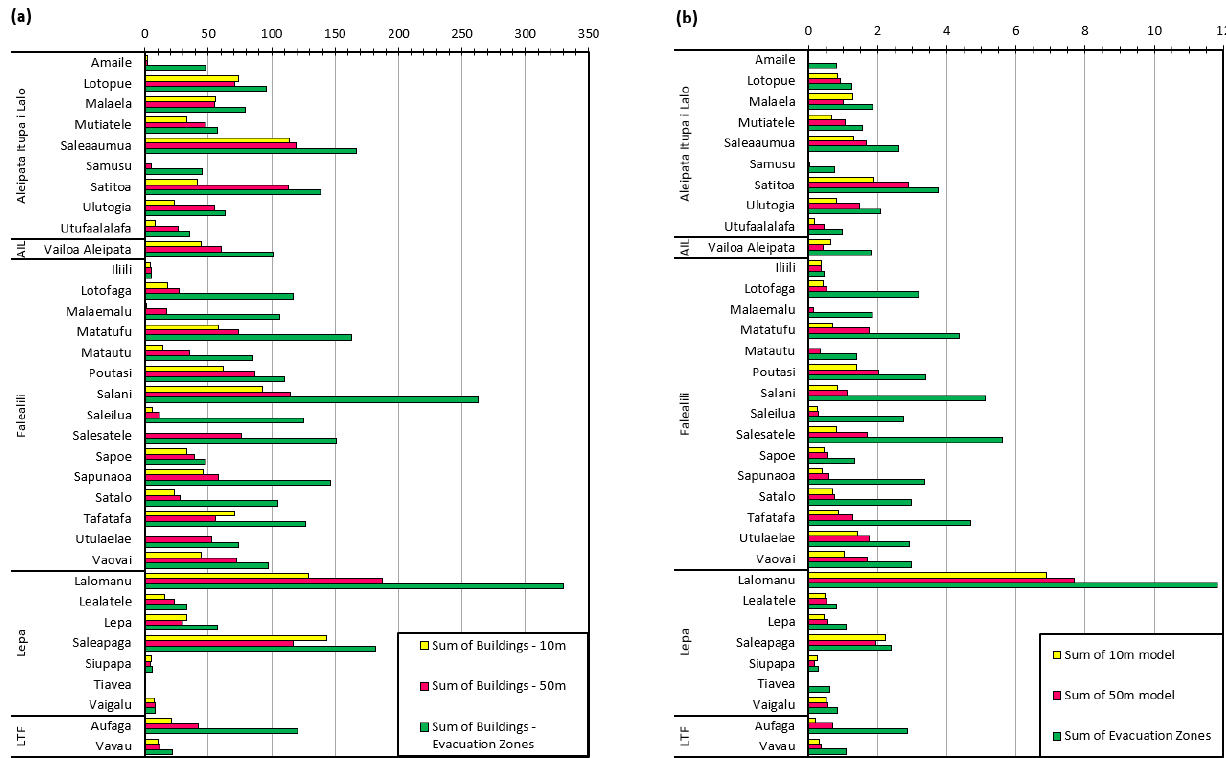
Figure 6. Comparison of exposure distributions between the 10 m, 50 m, and total evacuation zones for selected villages along SE Upolu. ( a ) Buildings. ( b ) Roads (km).